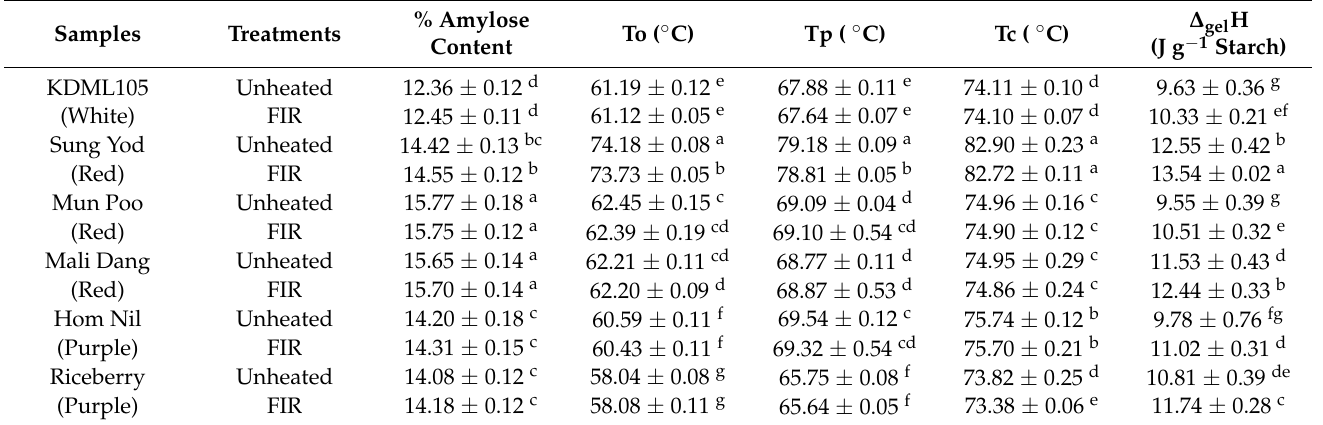
Table 3. Gelatinization parameters of pigmented rice varieties as affected by